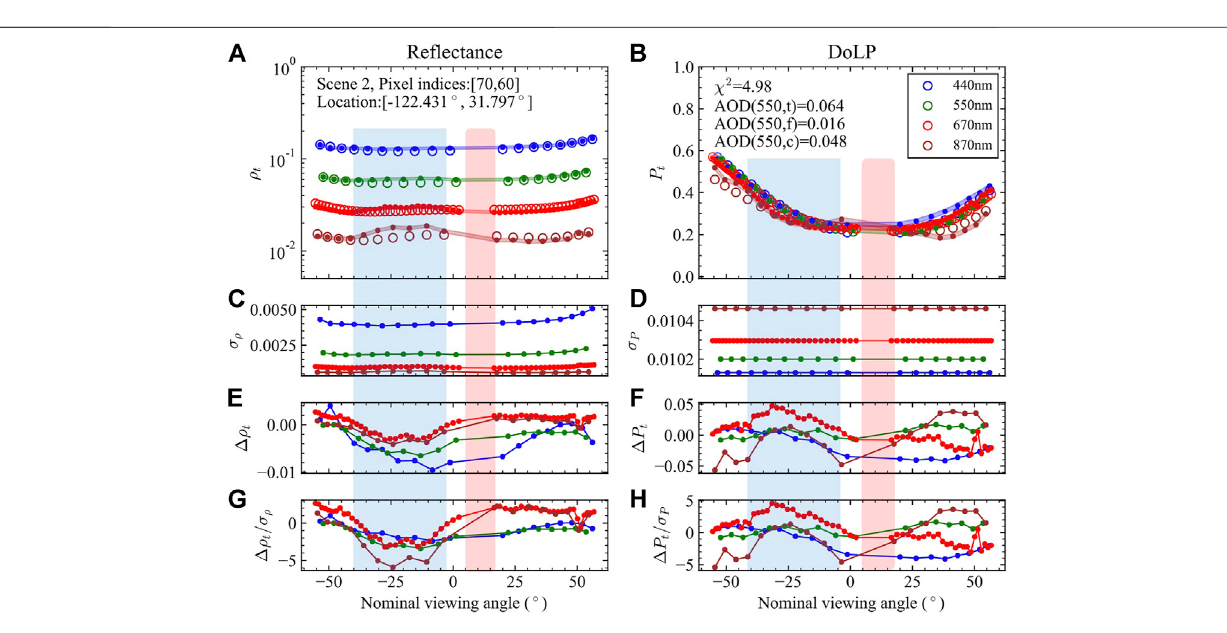
Frontiers in Remote Sensing |